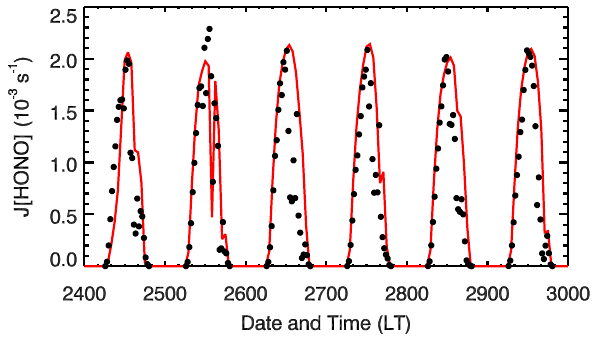
Fig. 4. Simulated and observed photolysis rate of HONO at T0 during 24–29 March 2006. The black dots denote the observation and the red represents the simulations in the E-case.